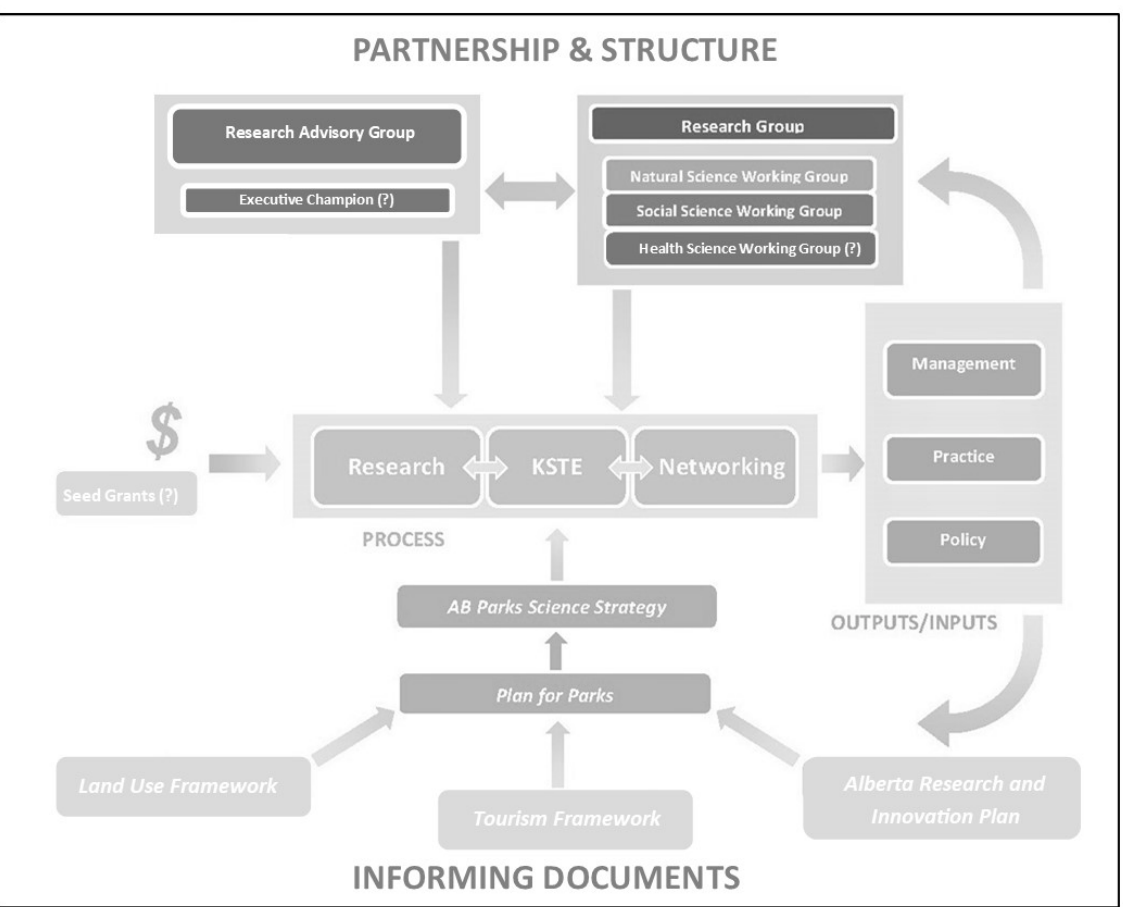
Figure 2. The organizational dimensions and process of the Social Science Framework.